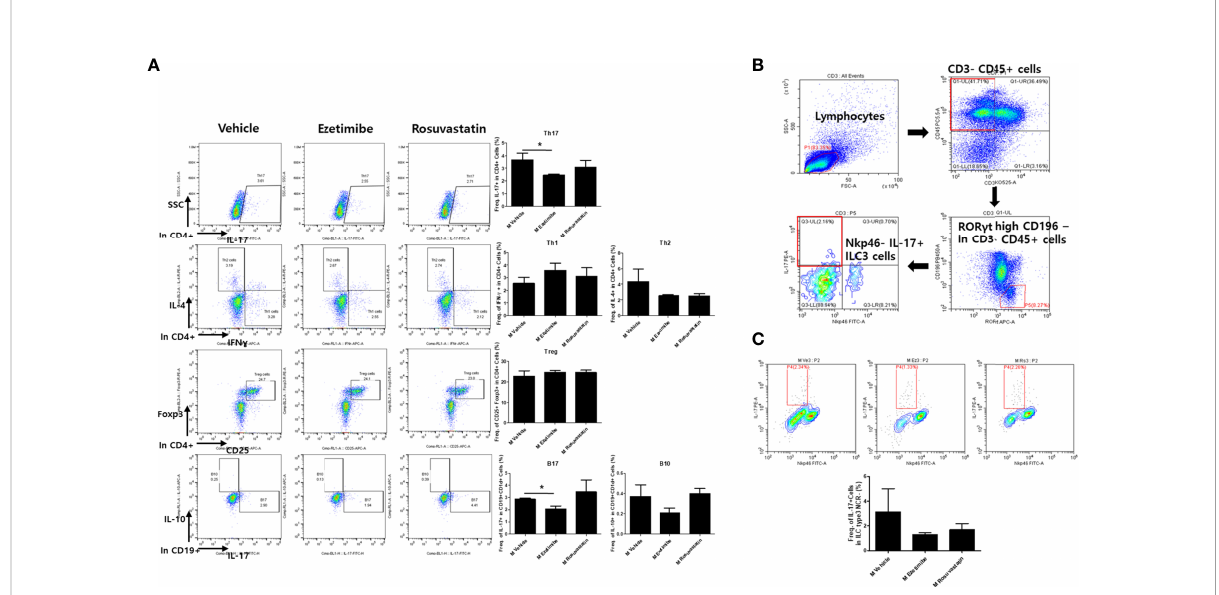
FIGURE 2 Role of ezetimibe in regulation of IL-17-producing immune cell populations in AS mice. (A) The numbers of CD4+IL-17+ (Th17), CD4+IFN g + (Th1), CD4+IL-4+ (Th2), CD4+CD25+Foxp3+ (Treg), CD1d+CD19+IL-17+ (B17), and CD1d+CD19+IL-10+ (B10) cells of mouse splenocytes were measured by ex vivo fl ow cytometry. (B) Gating strategy for IL-17-producing ILC3 cells. (C) IL-17+ ILCs in mouse splenocytes detected by fl ow cytometry. Values are means ± SEMs of three independent experiments. *p <